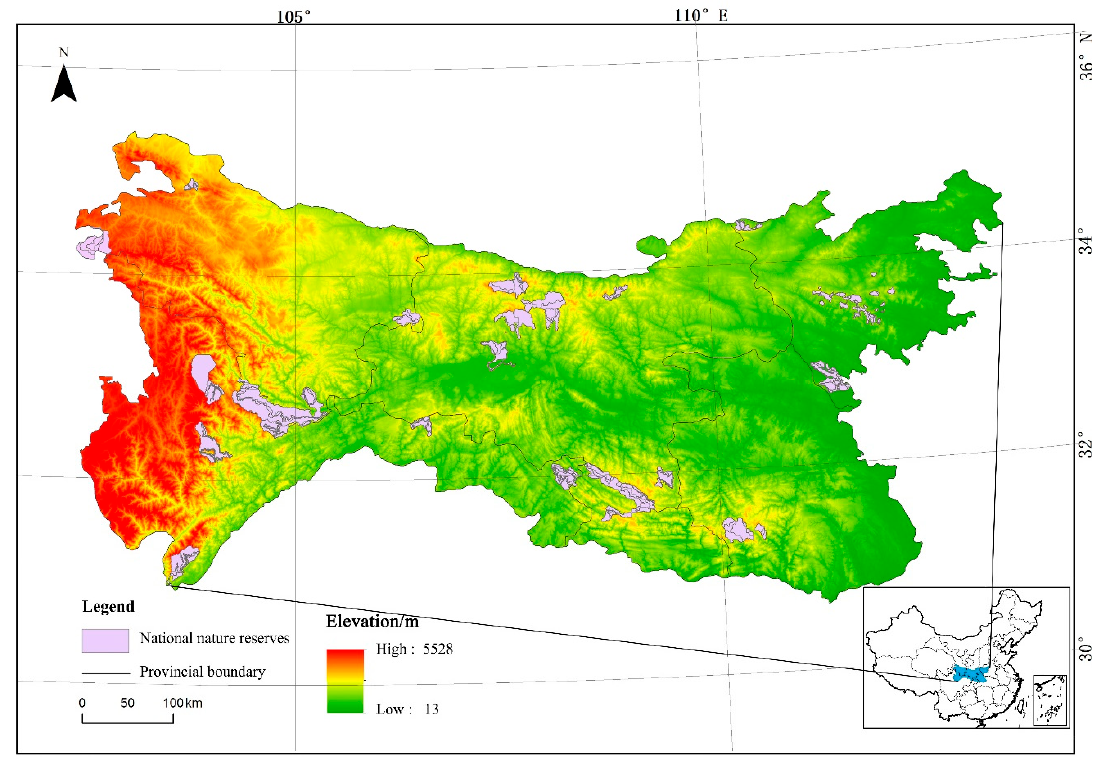
Figure 1. Distribution of national nature reserves in the Qinling–Daba Mountains .